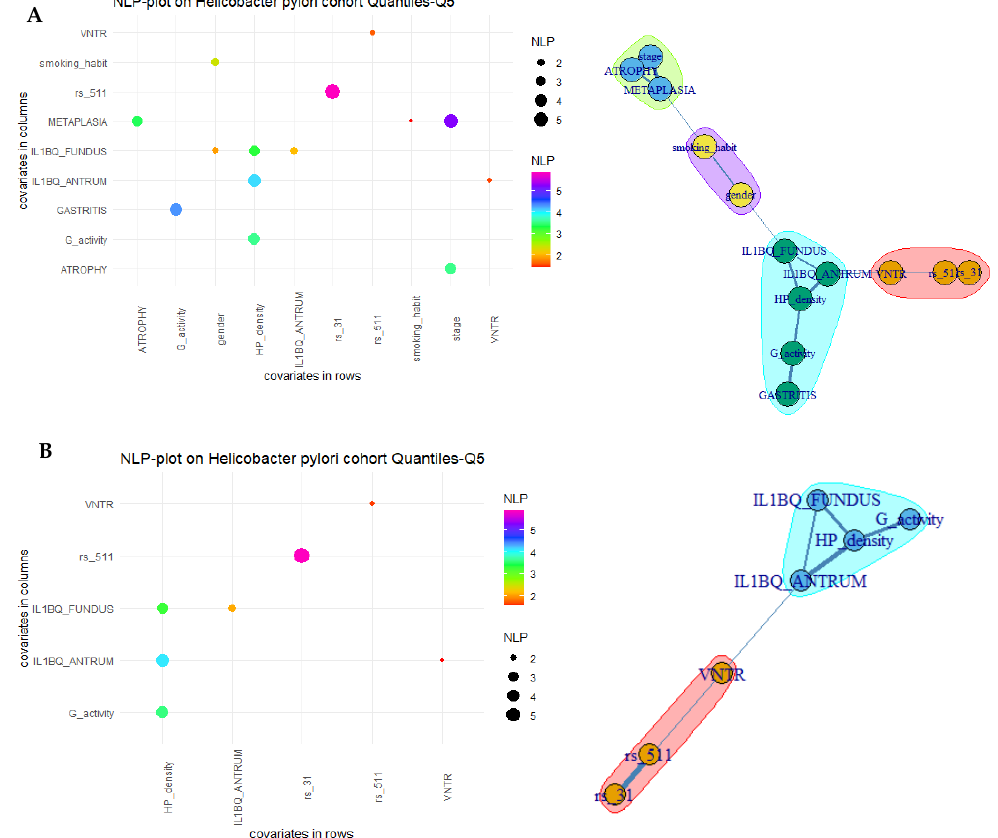
Figure 2. Iterative chi-square tests between categorical variables of the study: ( A ) negative log10 p -value plot (NLP plot) and Louvain clustering network including clinical, epidemiological, genetic and IL-b parameters; ( B ) negative log10 p -value plot (NLP plot).